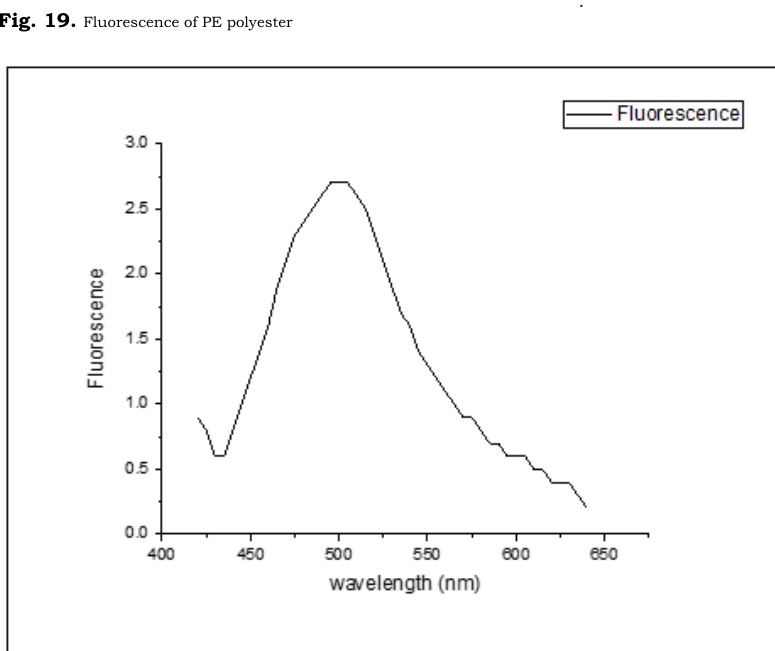
Fig. 20. Fluorescence of PF